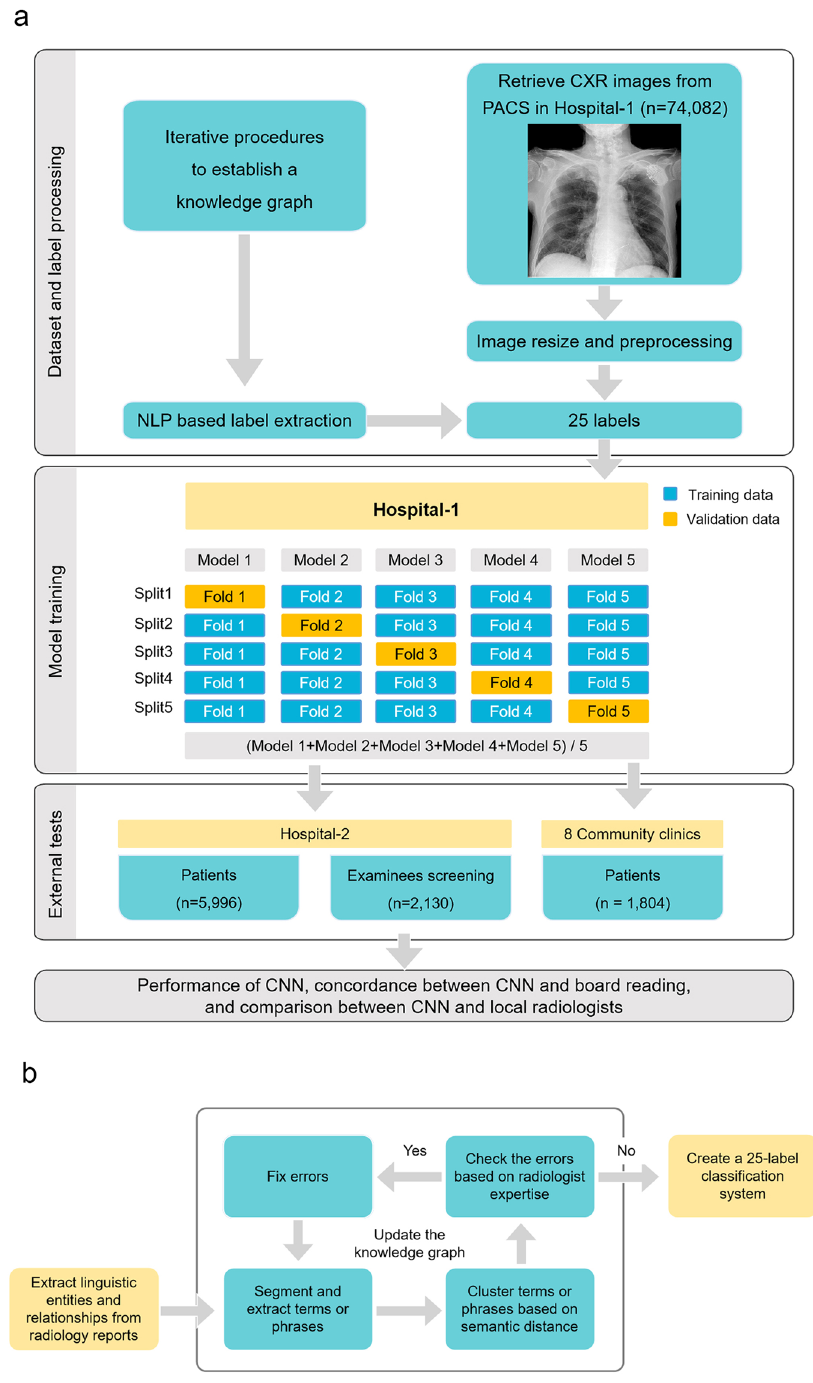
Fig. 1 Diagram of research steps. a Work fl ow of dataset preparation, model training, and external testing. The training dataset consists of chest X-ray radiographs (CXR) and corresponding diagnostic reports. By using the bidirectional encoder representations from transformers (BERT) model to identify language entities from the reports, we conducted an iterative process to build a knowledge graph with the semantic relationship between language entities and fi nally established 25 labels representing 25 abnormal signs in CXR. After training the convolutional neural networks (CNNs) based on fi vefold strati fi ed cross-validation and weakly supervised labeling, we conducted external tests in another hospital and eight community clinics. The tests included the performance of CNN, the concordance between CNN and board reading, and the comparison between CNN and local radiologists. b Work fl ow of image labeling based on the bidirectional encoder representations from transformers (BERT) natural language processing model with an expert amendment. We used the BERT model to recognize linguistic entities, entity span, semantic type of entities, and semantic relationships between entities. In an iterative process to establishing the knowledge graph with the semantic relationship between language entities, two radiologists examined the established knowledge graph, amended the extracted linguistic entities, and clari fi ed linguistic relationships based on their clinical experience. Finally, 25 labels representing 25 abnormal signs were established. CXR chest X-ray radiography, BERT the bidirectional encoder representations from transformers, CNN convolutional neural network, PACS picture archiving and communication system, NLP natural language processing.